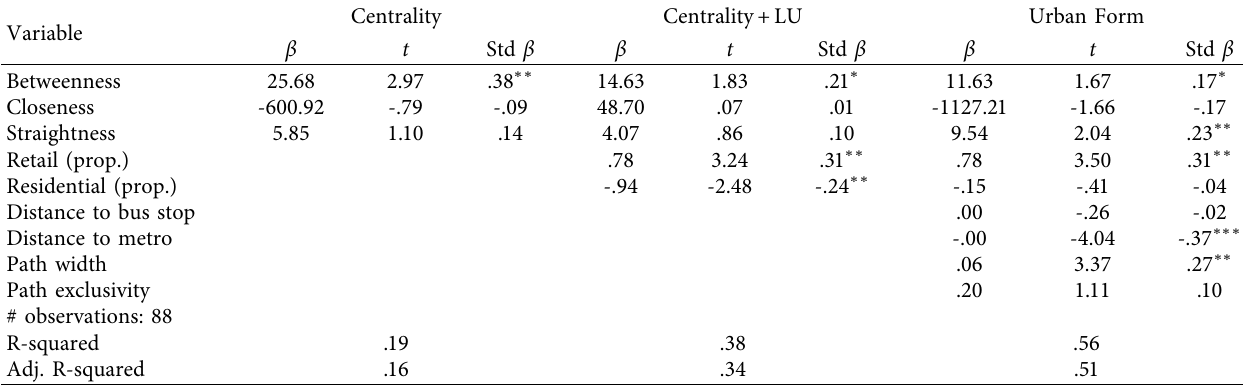
Table 7: Taipei-Songjiang Nanjing: multivariate regression